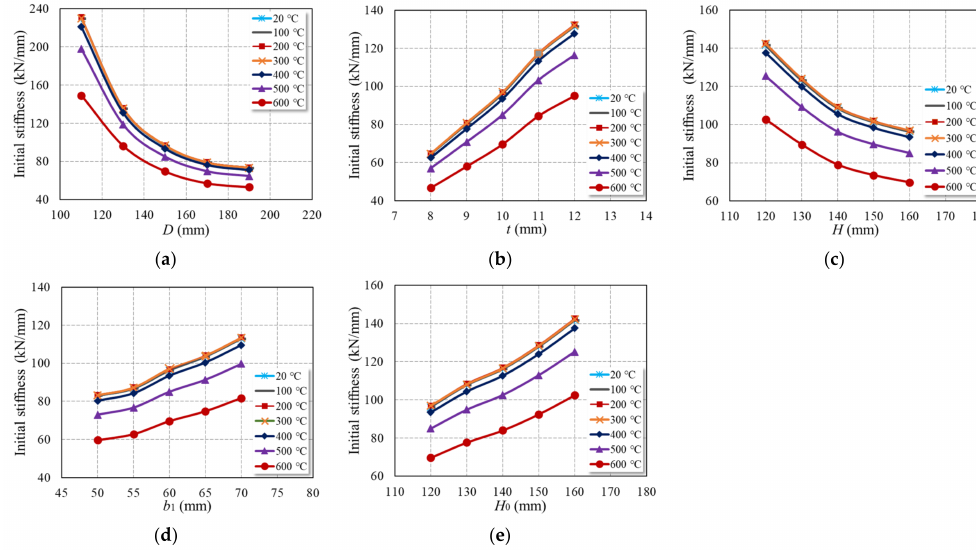
Figure 9. Effects of parameters on the initial stiffness of BBC joints under compression: ( a ) outer diameter of the tube; ( b ) thickness of the tube; ( c ) height of the tube; ( d ) width of the tubular beam; ( e ) height of the tubular